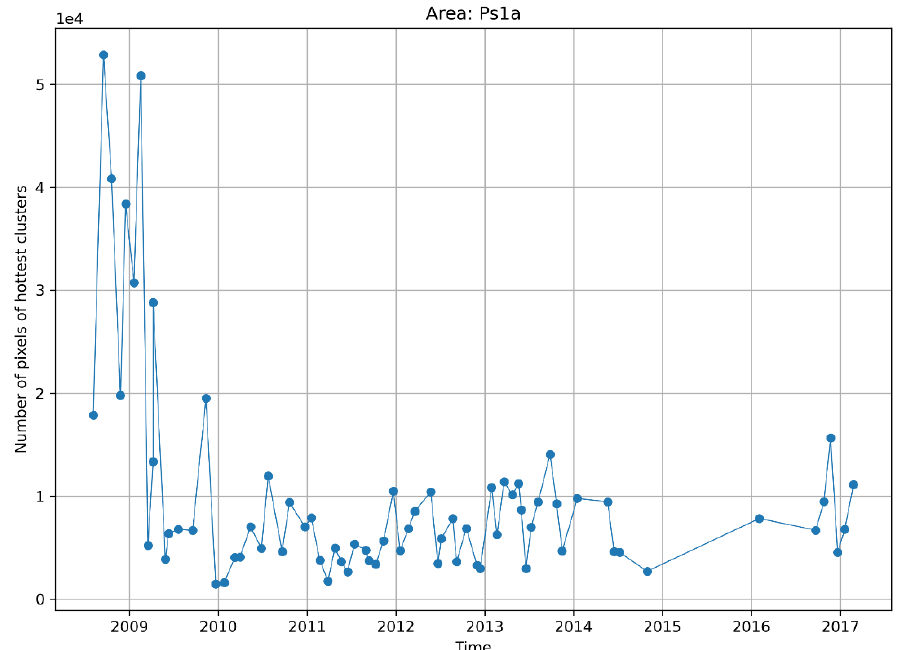
Figure 14. Trend of the average number of pixels of the three hottest clusters of the thermal images taken in the Pisciarelli area (Campi Flegrei), indicated as “Ps1a” in Figure 1, acquired between 2008 and